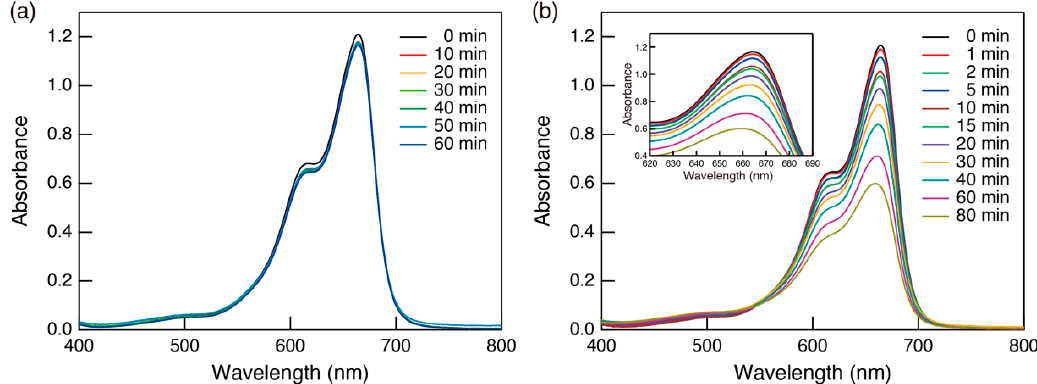
Figure 4. Visible absorption spectra of methylene blue (MB) aqueous solutions sampled from the solution containing mesoporous TiO 2 /BDD at various times ( a ) in the dark and ( b ) during photocatalytic activity test under 222 nm UV